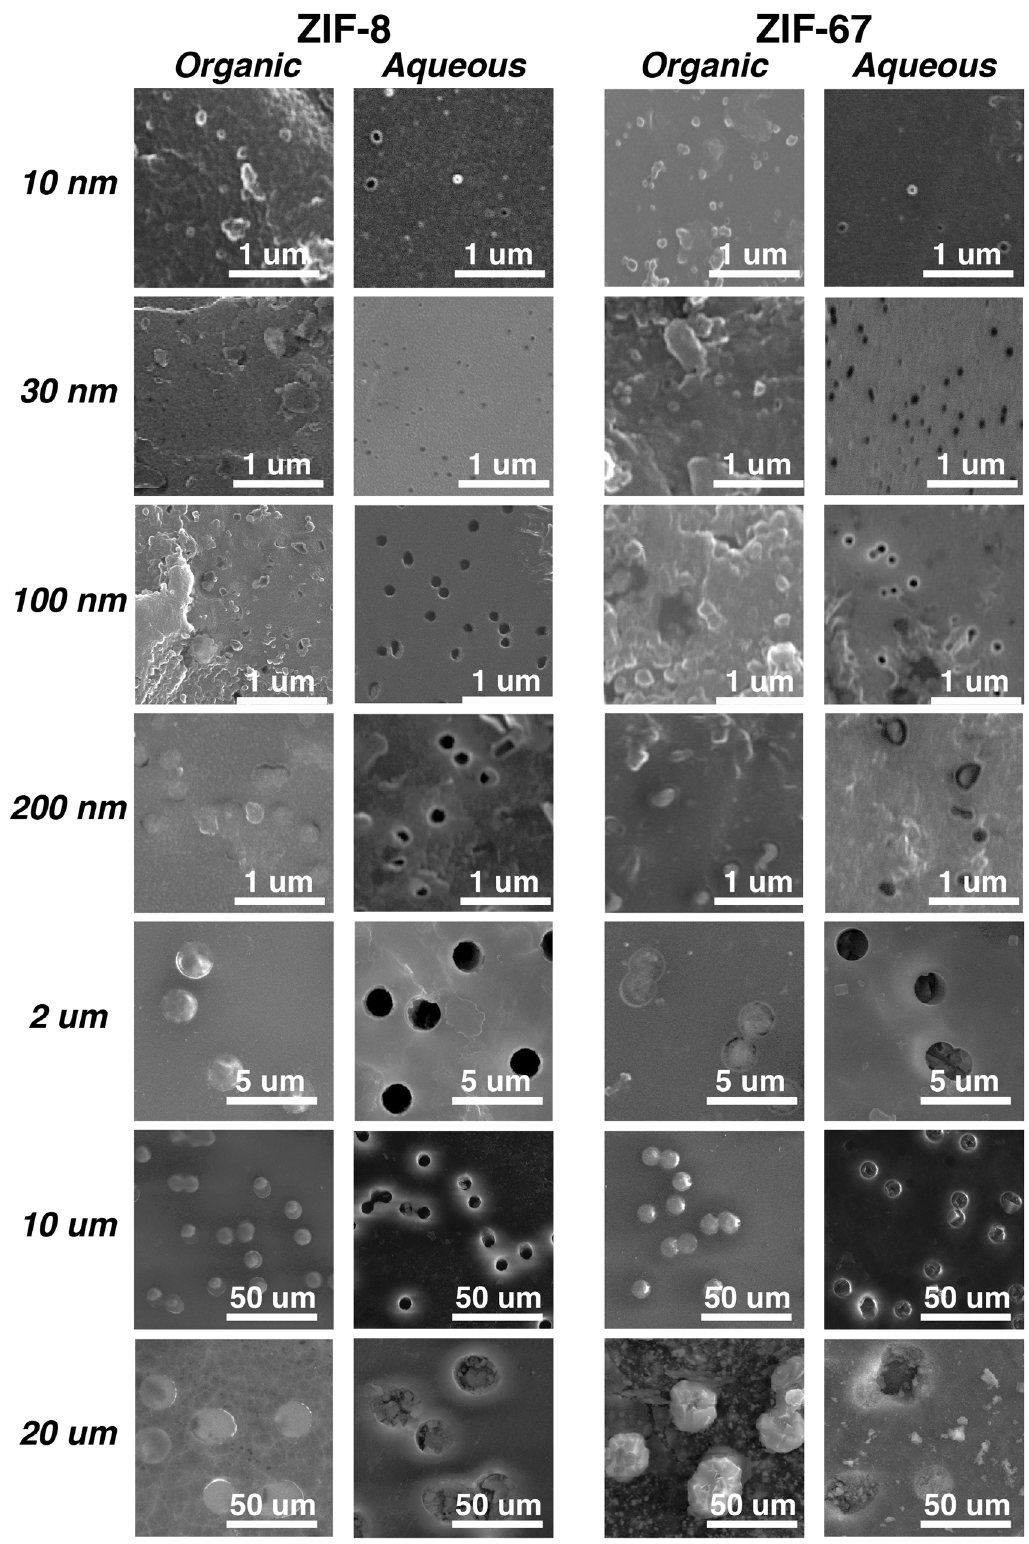
Fig. 3 Scanning electron microscopy (SEM) analyses. SEM images of both organic and aqueous facing surfaces of track-etched polycarbonate (PCTE) templates of various pore sizes containing ZIF-8 and ZIF-67 nano- and micro-structures after interfacial